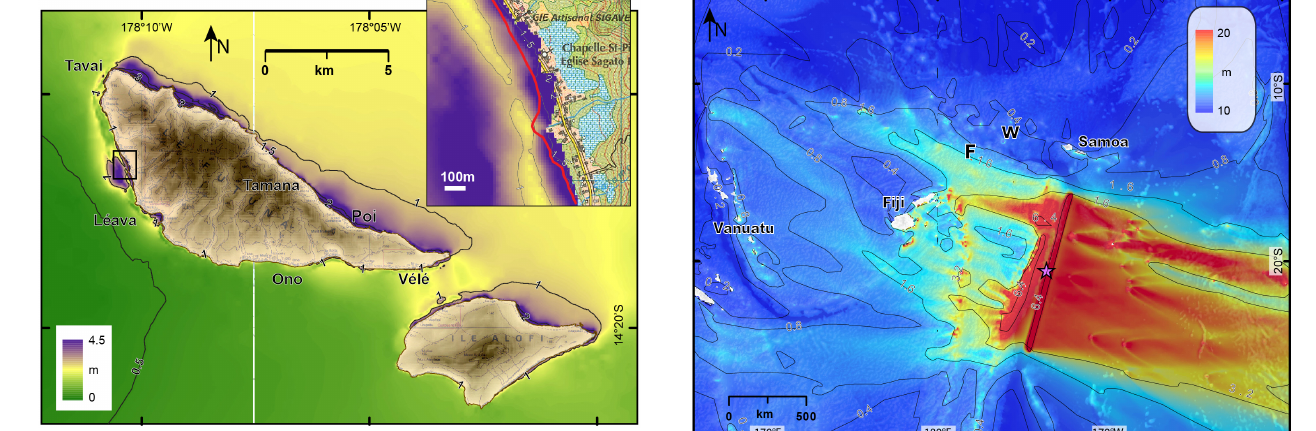
Figure 8. Tsunami maximum wave elevation (in m) generated by the full rupture of the Tonga Trench (Sc. 8, Table 4). Model gener- ated using the Gerris flow solver. F: Futuna, W: Wallis. The star is the